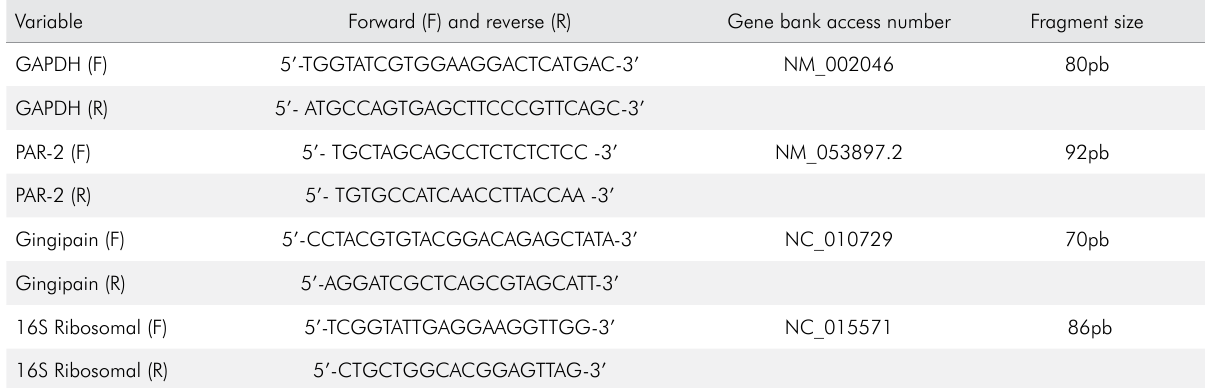
Table 1. Sequence of primers used for cDNA